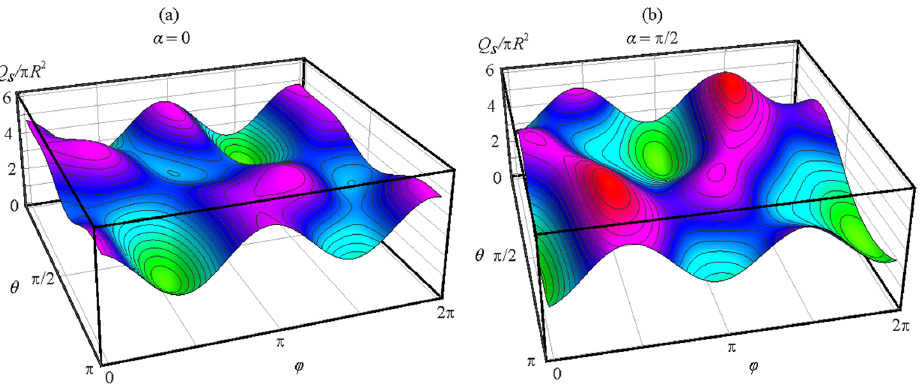
(cid:0) (cid:1) Figure 4. Reduced scattering cross ‐ section 𝑄 (cid:3046) / (cid:4666)𝜋𝑅 (cid:2870) (cid:4667) for all incidence angles 𝜃 and 𝜙 for a bian ‐ Figure 4. Reduced scattering cross-section Q s / π R 2 for all incidence angles θ and φ for a bian- isotropic sphere with the effective material parameters color ‐ coded in Figure 1b and with 𝑥 (cid:3404) isotropic sphere with the effective material parameters color-coded in Figure 1b and with x = k 0 R = 1; 𝑘 (cid:2868) 𝑅 (cid:3404) 1 ; In panel ( a ), the incidence polarization angle is 𝛼 (cid:3404) 0 ; in ( b ) 𝛼 (cid:3404) 𝜋 /2 . The color of the In panel ( a ), the incidence polarization angle is α = 0; in ( b ) α = π /2. The color of the surface corre- surface corresponds to the magnitude of 𝑄 (cid:3046) / (cid:4666)𝜋𝑅 (cid:2870) (cid:4667) (cid:0) (cid:1) π R 2 sponds to the magnitude of Q s /